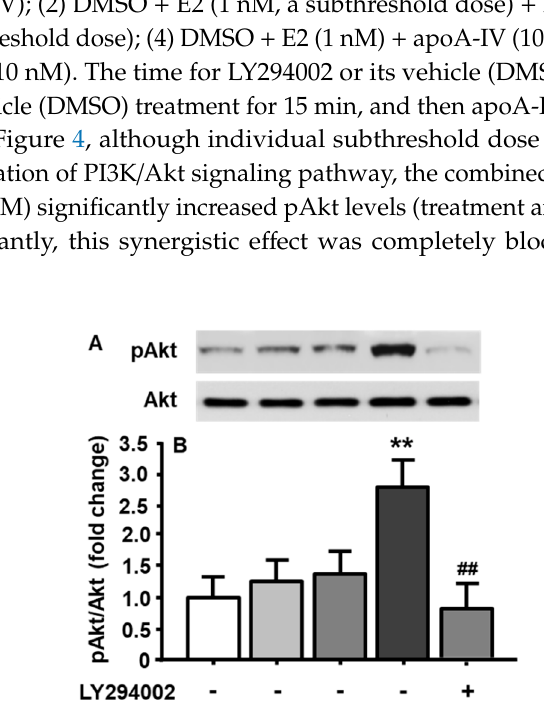
Figure 3. ApoA-IV activated PI3K/Akt signaling pathway in cultured neuronal cells. ApoA-IV (100 nM) time-dependently increased the phosphorylation of Akt ( A , B ). When treated for 15 min, apoA-